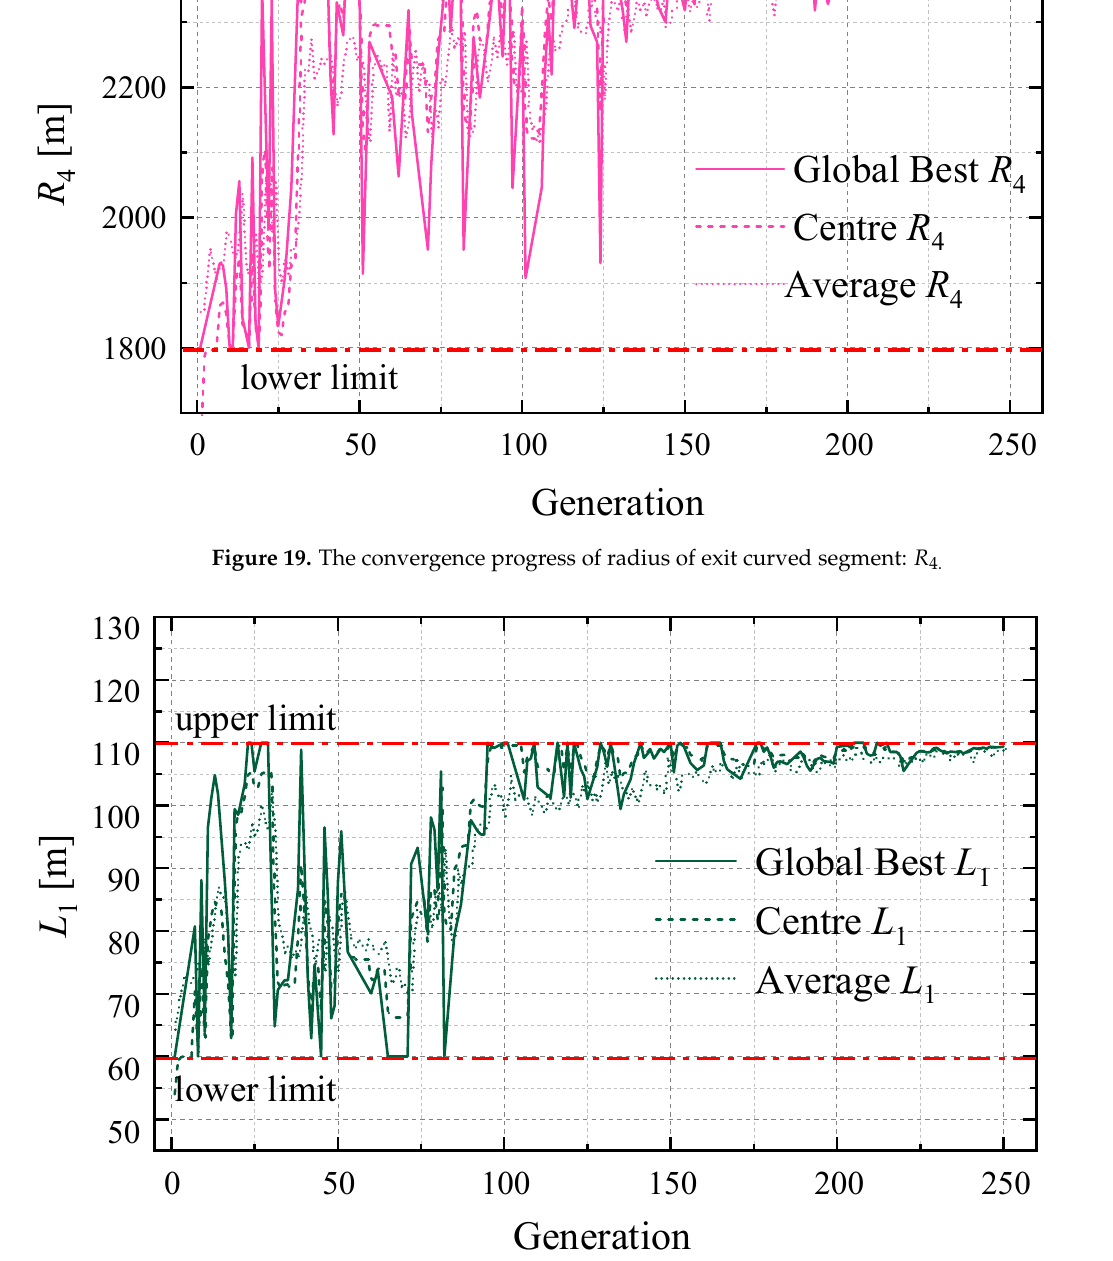
Figure 20. The convergence progress of length of entry straight segment: L 1.